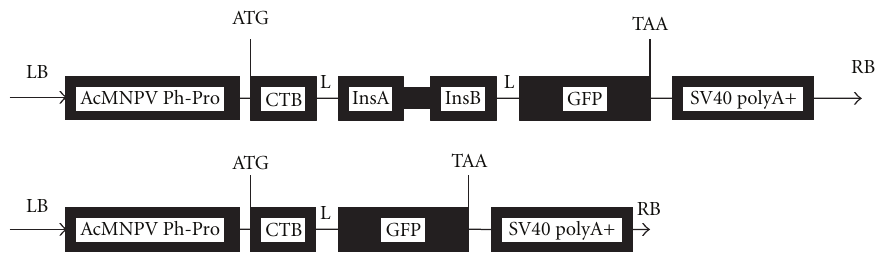
Figure 1: Schematic structure of the CTB-Ins-GFP fusion gene. AcMNPV Ph-Pro: Autographa californica multiple nuclear polyhedrosis virus polyhedrin promoter, CTB: cholera toxin B subunit, L: linker peptide (GPGP), InsA: human insulin subunit A, InsB: human insulin subunit B (InsA and InsB are linked by mini-C peptide (RRGSKR)), GFP: green fluorescent protein, and LB and RB: left and right border, respectively, of the donor vector